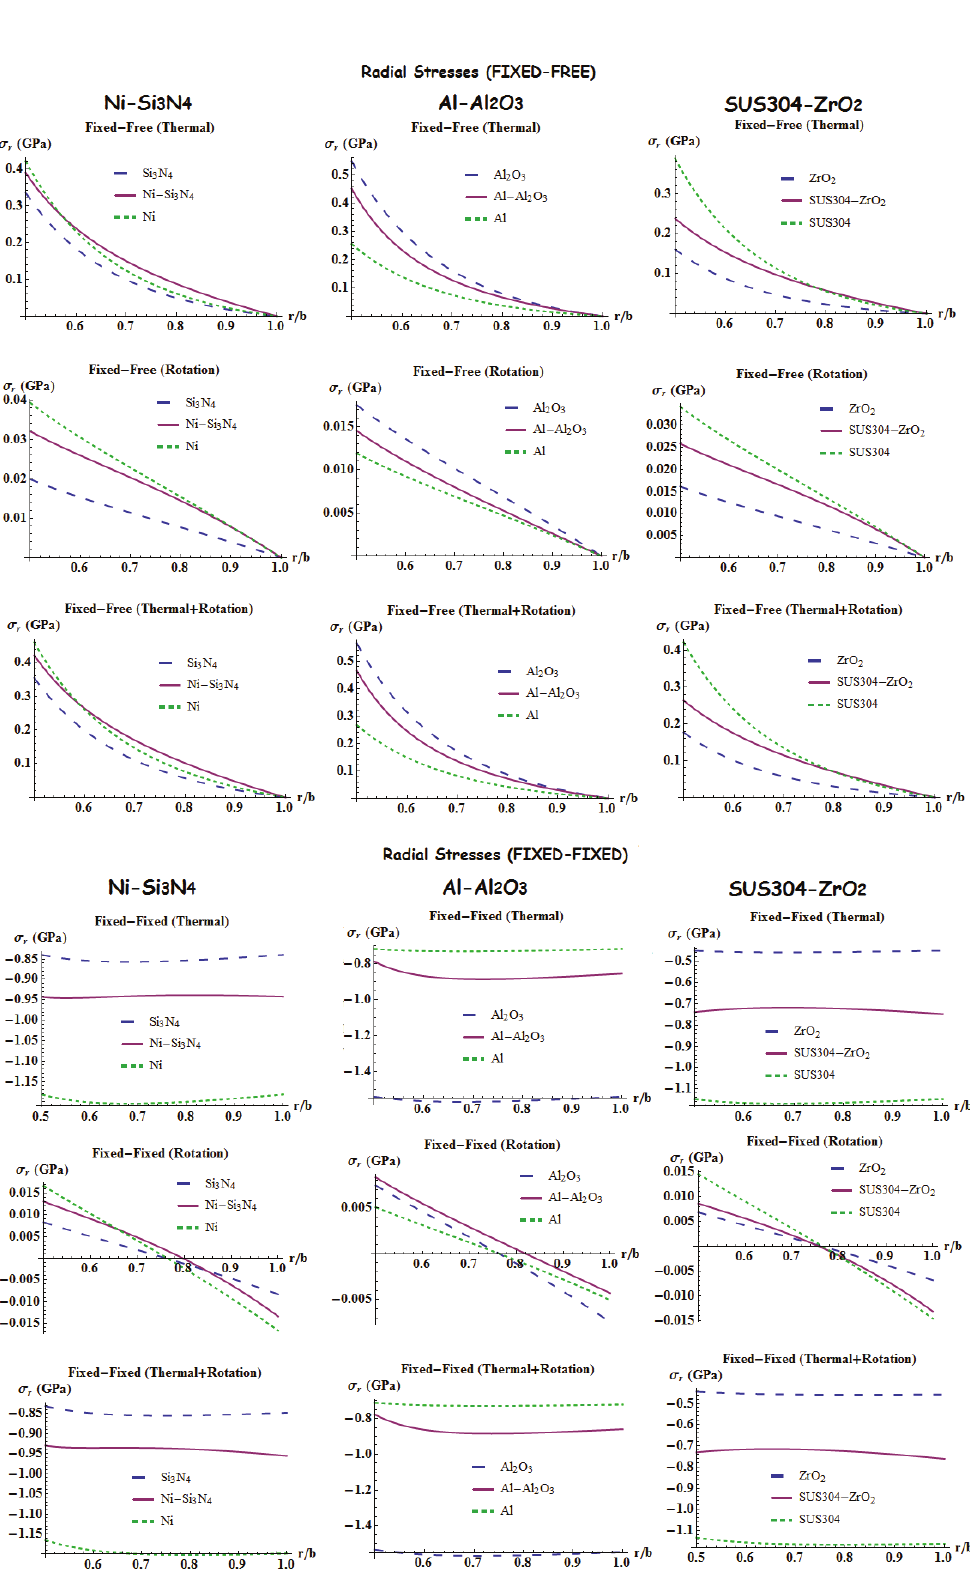
Figure 5. Variation of the radial stresses.